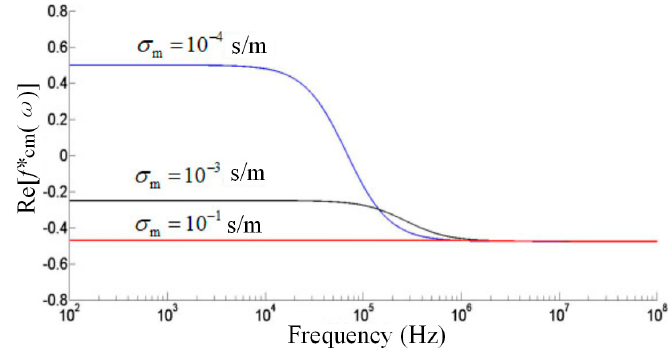
Figure 7. CM factor curve of the polystyrene particles.